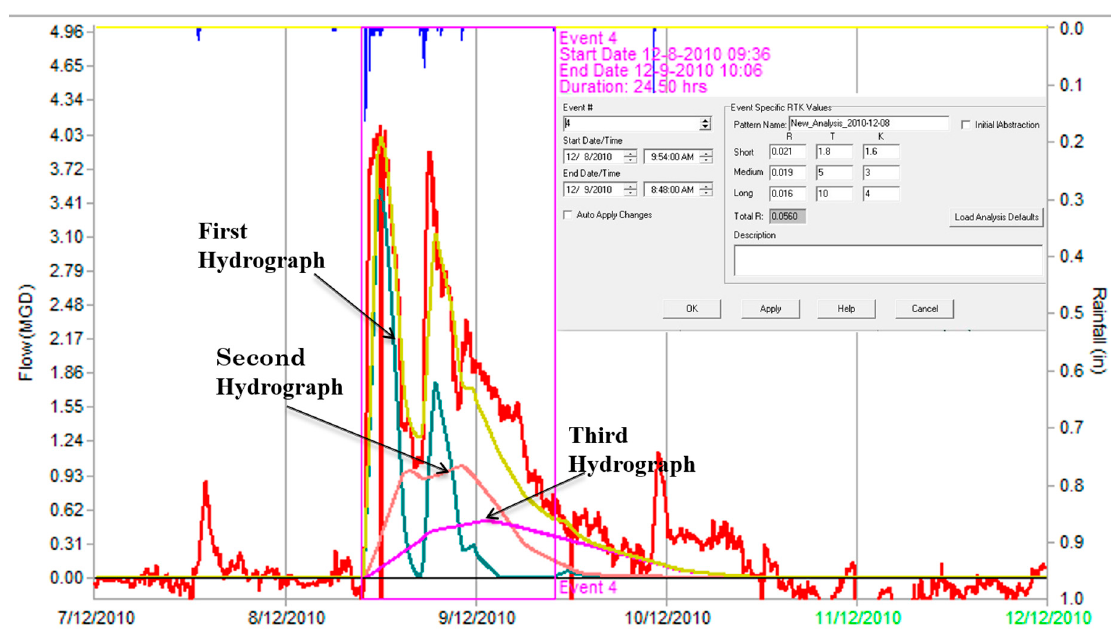
Figure 4. Estimation of the R, T, K parameters based on the triangular unit hydrograph method in the SSOAP toolbox.